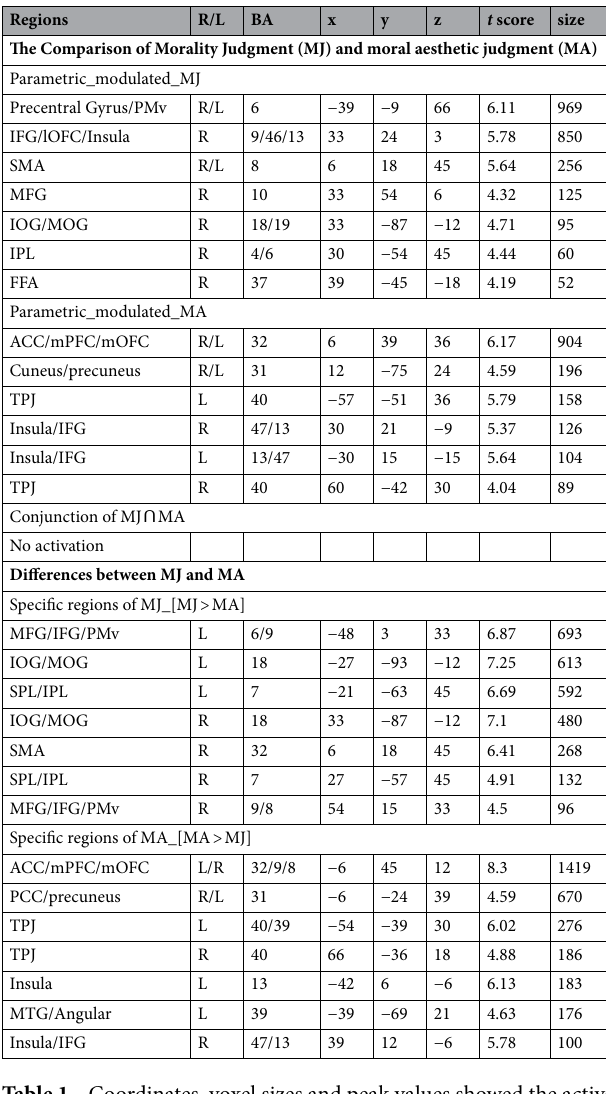
Table 1. Coordinates, voxel sizes and peak values showed the activated brain regions of MJ and MA (p < 0.05, FWE-corrected). Note: The t-scores computed by SPM12 quantify the statistical difference between the two conditions. Coordinates refer to the stereotactic space of the Montreal Neurological Institute. MFG Middle Frontal Gyrus, IFG Inferior Frontal Gyrus, SMA Supplementary Motor Area, IOG/MOG Inferior/Middle Occipital Gyrus, SPL/IPL Superior/Inferior Parietal Lobule, FFA fusiform face area, ACC/PCC Anterior and Posterior Cingulate Cortex, mPFC Medial Prefrontal Cortex, mOFC medial Orbitofrontal Cortex, TPJ Temporo-Parietal Junction, MTG Middle Temporal